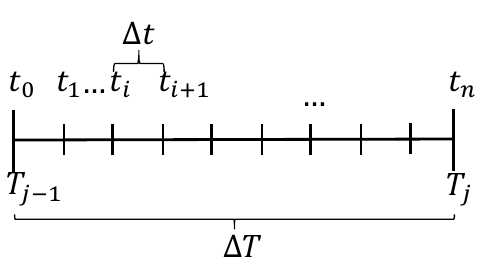
Figure 2. Visualisation of segmentation of the overall filtering time interval ∆ T in normalisation intervals ∆ t.